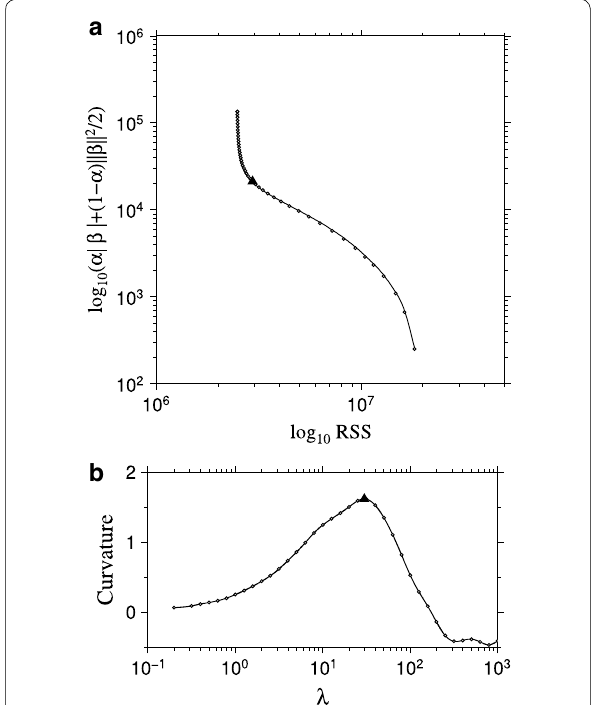
Fig. 22 a An L-curve obtained by CDA for L1–L2 norm regularized magnetic inversion. The open circles are the discrete L-curve 10 3 obtained by CDA for a decreasing sequence (cid:31) down from (cid:31) max = 10 − 1 with an interval of log 10 (� (cid:31) ) 0.1 on the log scale. to (cid:31) min = = The solid line is the interpolation curve of the discrete L-curve obtained by cubic spline. b The curvature of the interpolated L-curve. The solid triangles of these figures show the point where the curvature of the interpolated L-curve takes